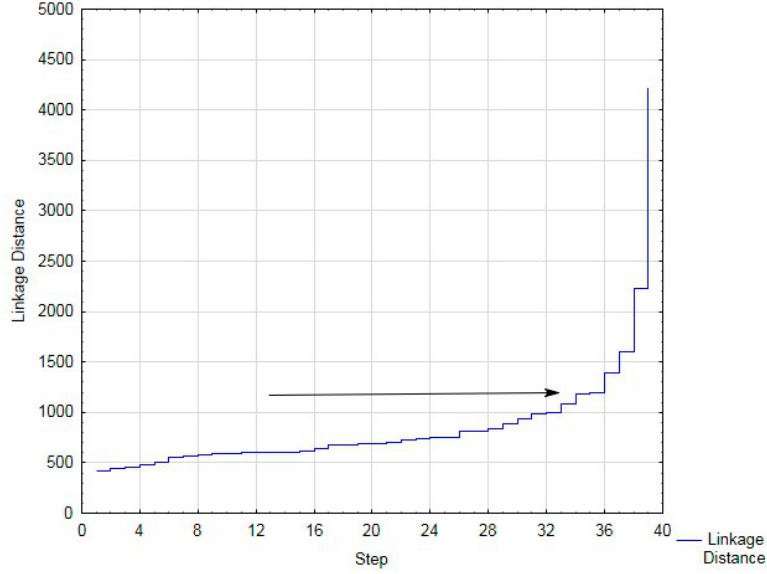
Figure A2. The plot of linkage distances across steps in personal dietary questionnaire cluster analysis. The arrow indicates the cut-off point and is equal to the distance of 1250.